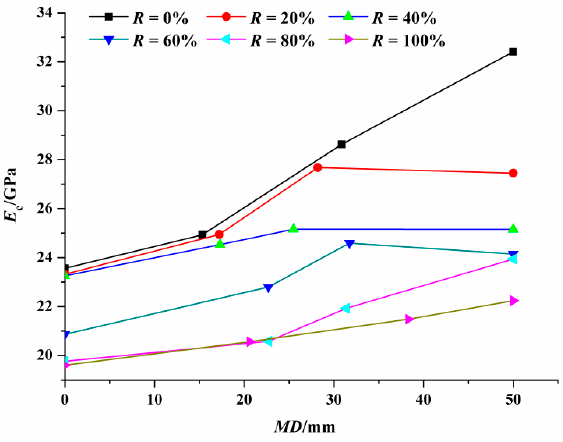
Figure 7. The E c of the RAC after carbonation versus the MD .